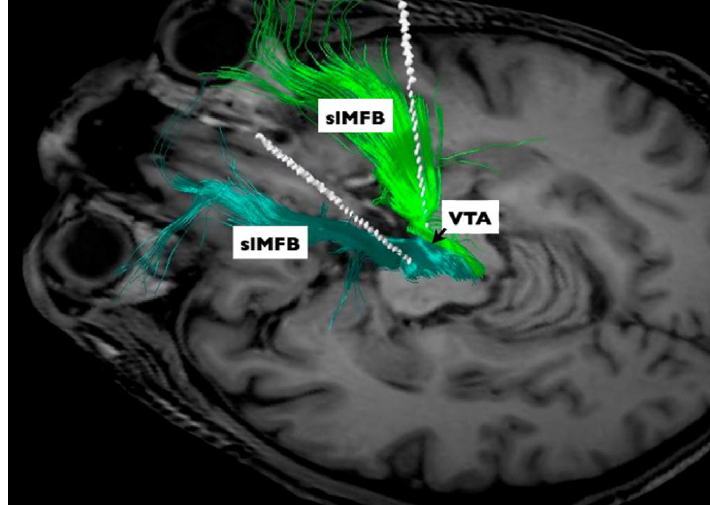
Figure 4. Medial forebrain bundle. Diffusion tensor imaging-based patient individual planning of bilateral supero-lateral medial forebrain bundle (slMFB) deep brain stimulation. Three-dimensional rendering as seen from posterior and superior left includes final DBS electrode positions (white rods). VTA, ventral tegmental area. Reprinted from Schlaepfer et al. [50]; with permission from Elsevier.